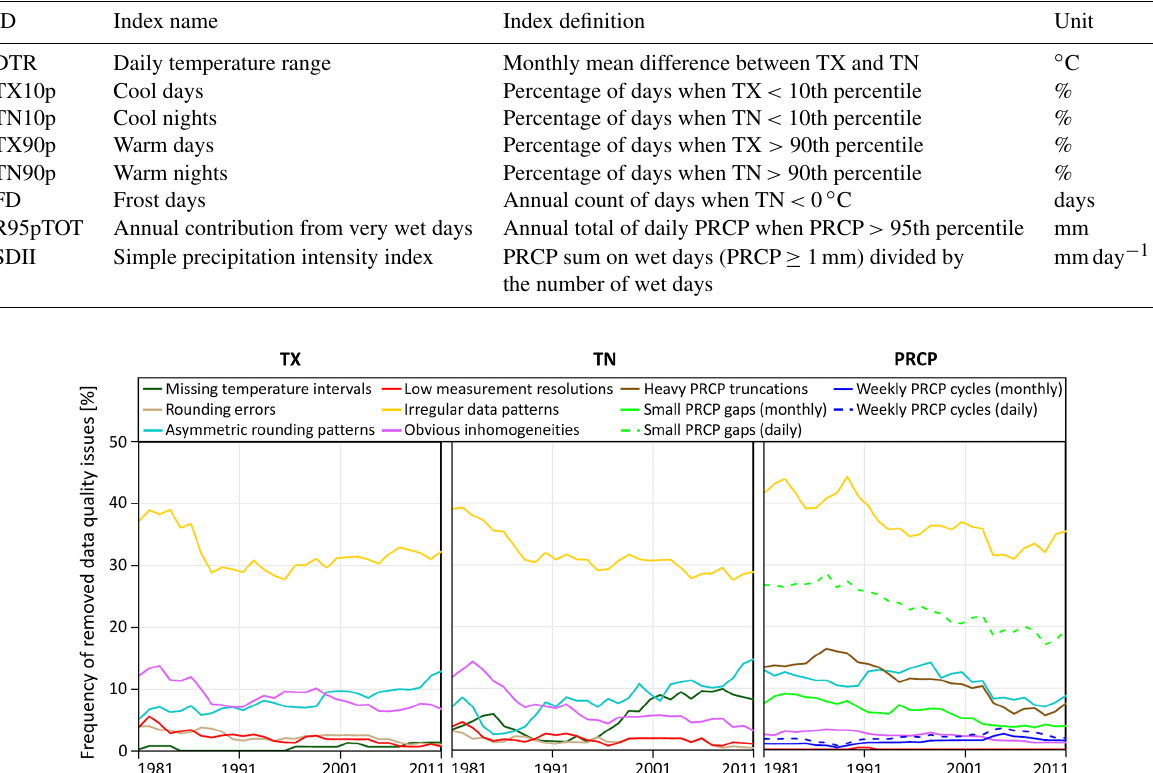
Table 2. ETCCDI climate change indices analysed in the present study. Note that all indices were calculated on an annual timescale. Index units in percentage were converted to days per year in the following analyses.